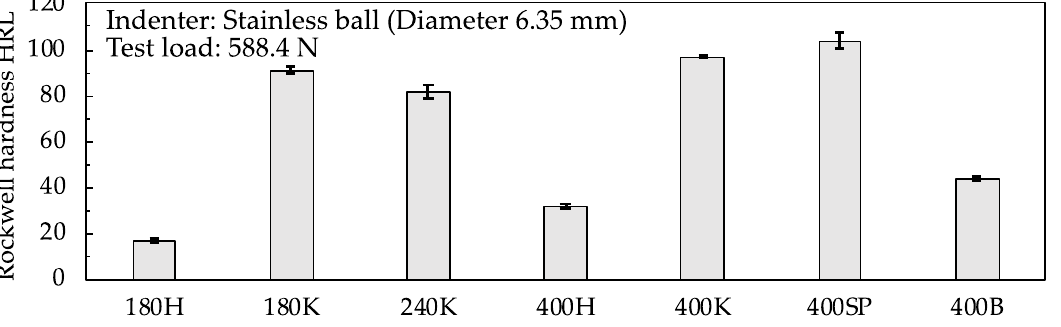
Figure 4. Rockwell hardness measurements of grinding wheels.